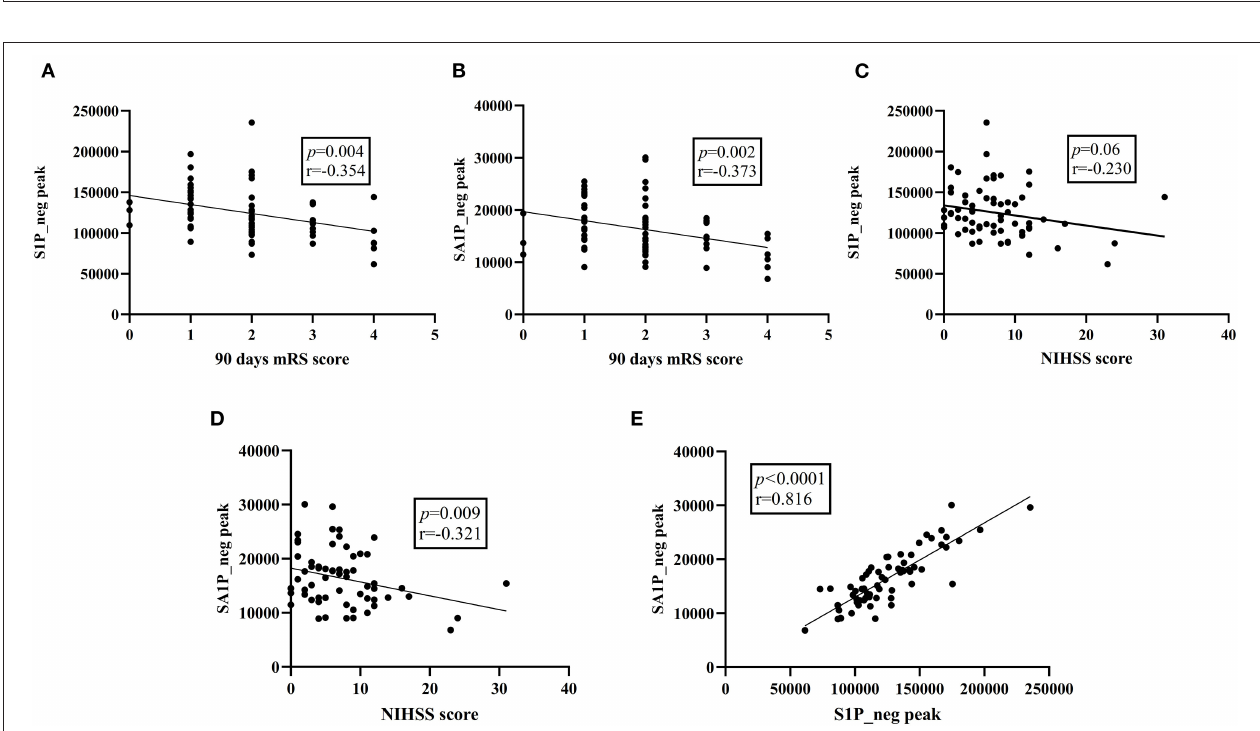
FIGURE 5 | Overall correlation between differential metabolites and clinical parameters. (A) S1P_neg levels showed a significant negative correlation with the 90-day mRS score. (B) SA1P_neg levels showed a significant negative correlation with the 90-day mRS score. (C) S1P_neg levels showed no significant correlation with the NIHSS score. (D) SA1P_neg levels showed a significant negative correlation with the NHISS score. (E) SA1P_neg levels showed a significant positive correlation with S1P_neg levels. S1P_neg, sphingosine-1-phosphate in negative ion mode; SA1P_neg, sphinganine-1-phosphate in negative ion mode; mRS, modified Rankin Scale; NIHSS, National Institutes of Health Stroke